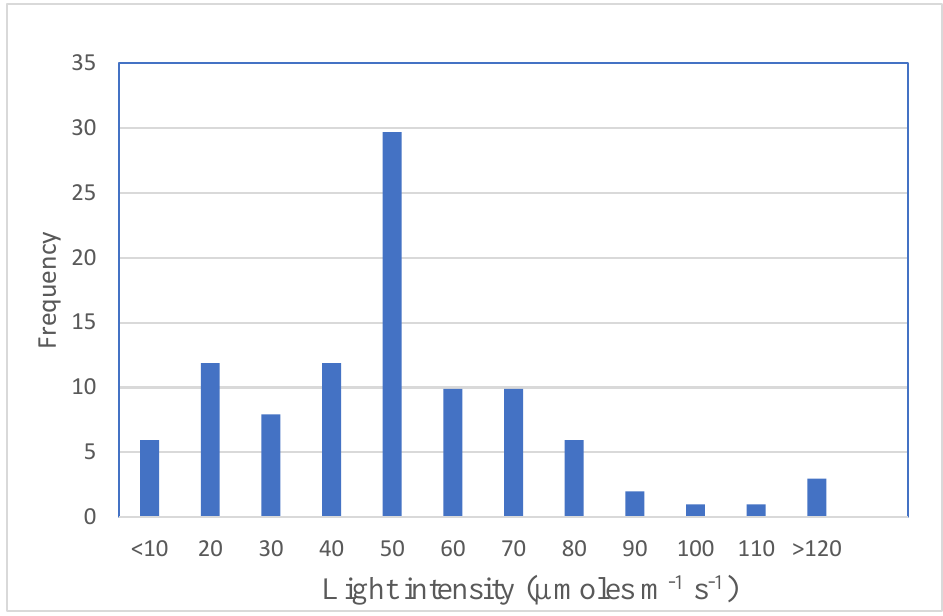
Figure 1. Frequency of light intensities used in literature for proliferation. In Rubus spp, rising WL fluence rates from 0 to 81 µ mol m − 2 s − 1 did not improve the organogenesis from cotyledons [225]. In Vaccinium corymbosum , exposure at rising intensities from 55 up to 210 µ mol m − 2 s − 1 improved proliferation and rooting ratios only with